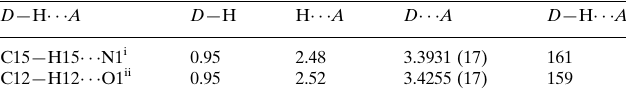
Hydrogen-bond geometry (A˚ , (cid:2)